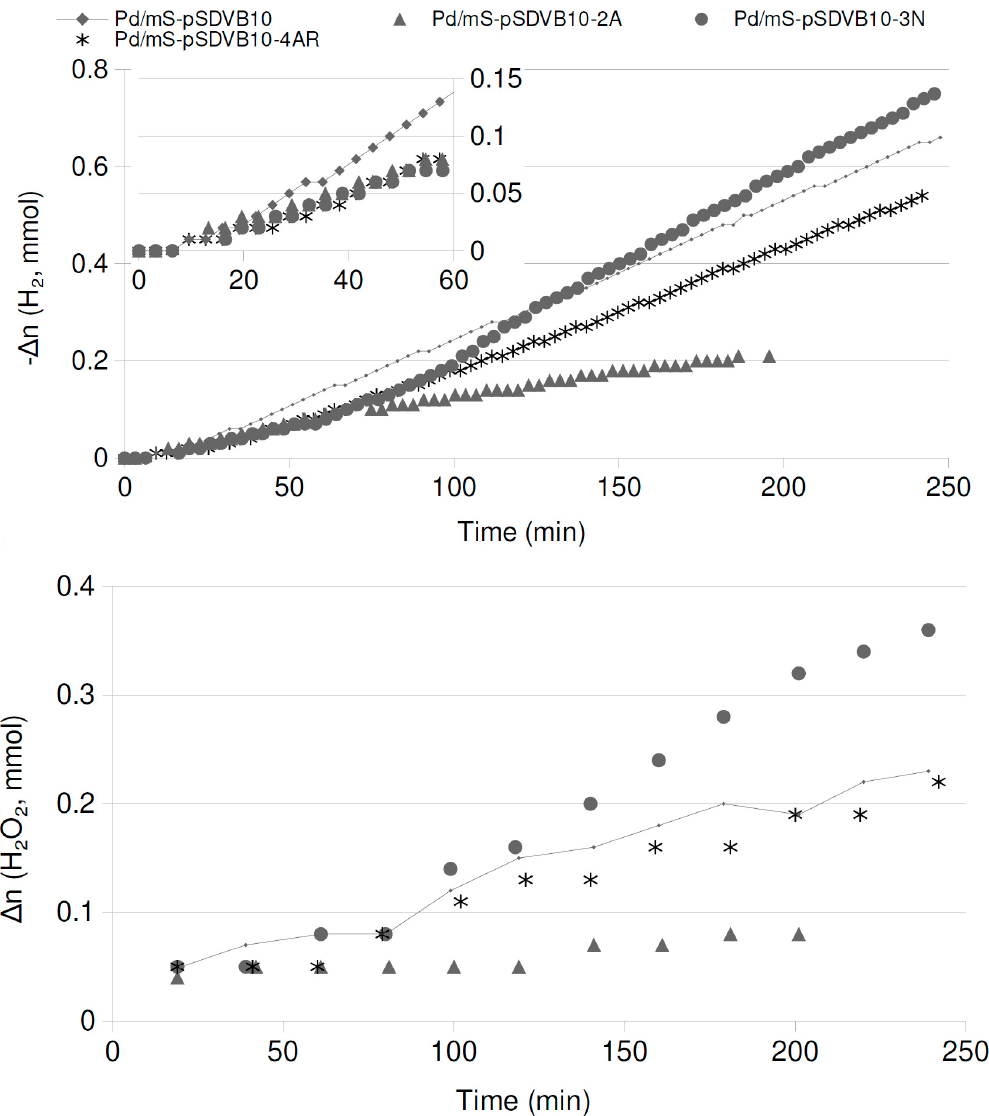
Figure 9. Overall amount of H 2 consumed ( top , mmol) and of H 2 O 2 formed ( bottom , mmol) over 100 mg of aged batches of Pd/ µ S-pSDVB10 as a function of time (the point connected with lines refer to the fresh catalyst).